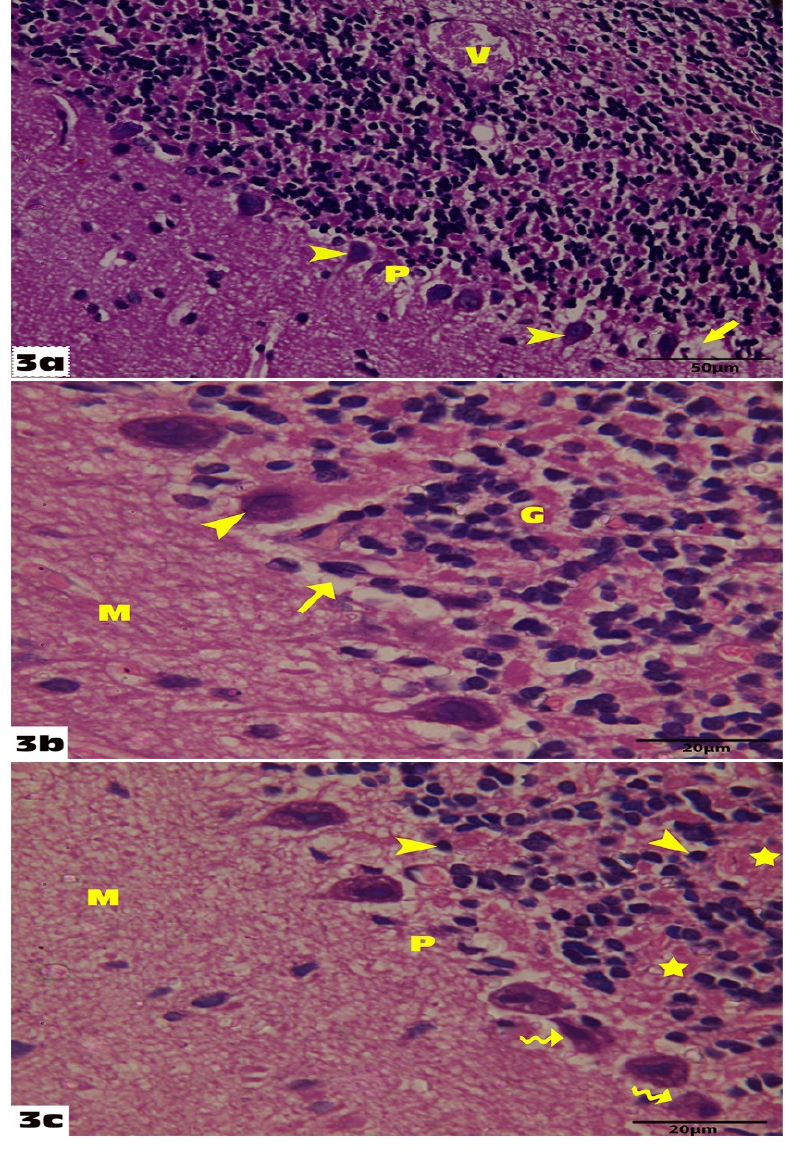
Figure 3. Sections from the rat cerebellum of group III: ( a ): Show that the Purkinje layer (P) retains its normal linear organization showing some normal cells (arrowheads), but other cells show irregular form and vacuolar spaces (arrow), and the granular layer shows nearly normal clumps of cells and shows a congested blood vessel (V) (H&E 400). ( b ): Shows irregular Purkinje cell with deeply stained pyknotic nucleus (arrowhead) and small vacuolated empty spaces (arrow); the remaining Purkinje cells are normal. The molecular layer (M) with scattered neurons appears nearly normal (H&E 1000). ( c ): Shows the granular layer with few shrunken cells with deeply stained nuclei (arrowhead), slightly enlarged glomerular spaces (stars), and the Purkinje layer shows normal organization with few irregular Purkinje cells (wavy arrows) (H&E 1000).